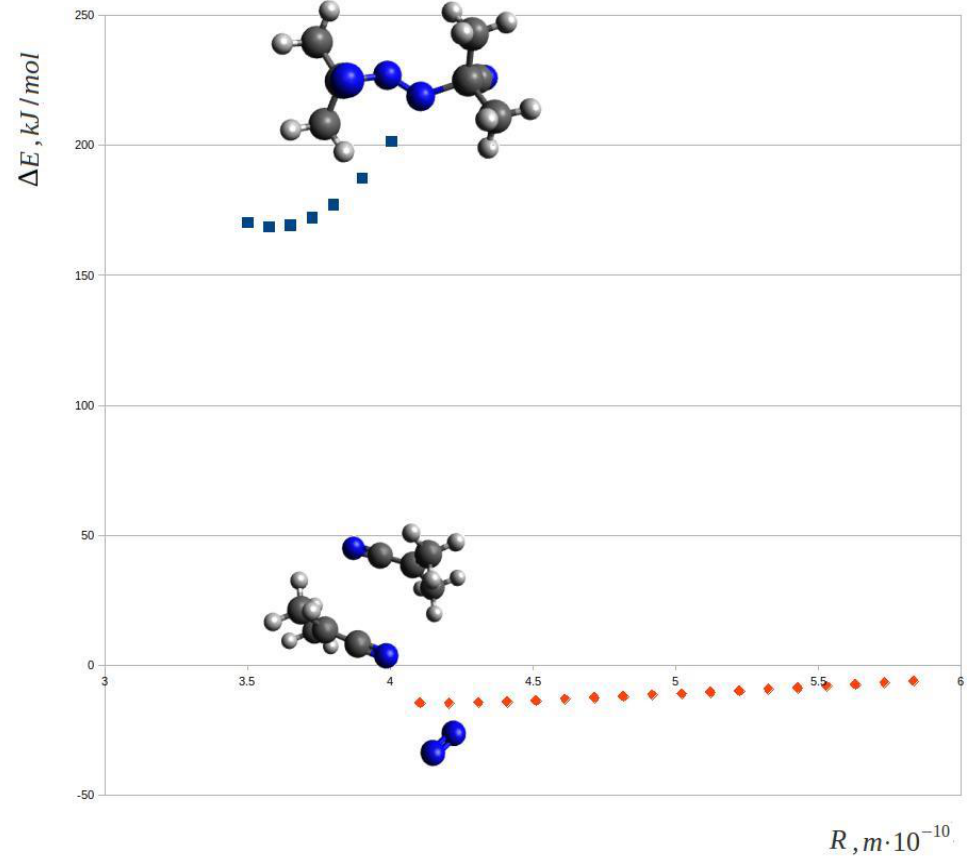
Figure 3. The dependence of the energy change relative to the global minimum of the AIBN molecule in the triplet state on the distance between carbon atoms C1 and C5 (Figure 1).